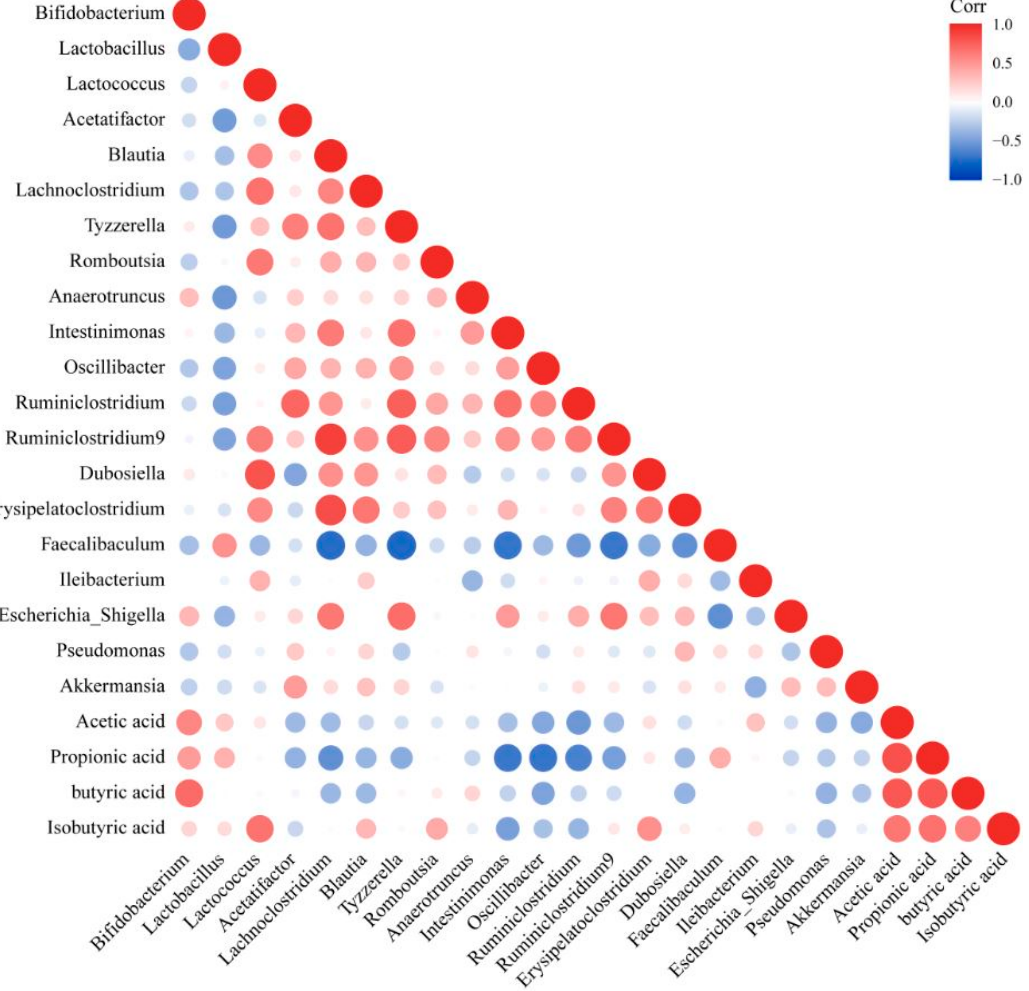
Figure 9. Correlation analysis between intestinal microbiota and SCFAs.